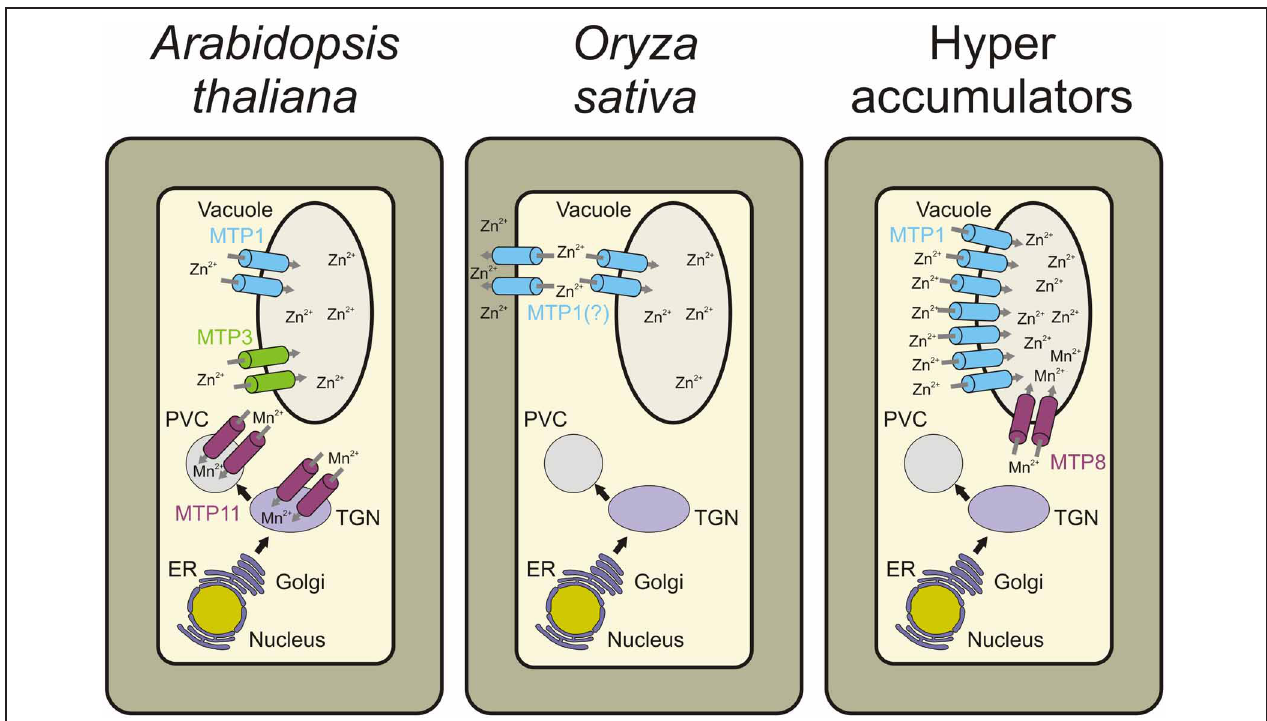
tonoplast-localized when heterologously expressed in yeast and Arabidopsis (Menguer et al., 2013). In Zn hyperaccumulators such as A. halleri , N. caerulescens , and N. goesingense , the MTP1 protein is highly expressed, being necessary for hypertolerance to high metal concentrations. In the Mn hyperaccumulator S. hamata , MTP8 transports Mn into the vacuole. Contrary to MTP1, the role of MTP8 in hyperaccumulation/hypertolerance seems to be more related to higher transport efficiency than to increased copy number (Delhaize et al.,